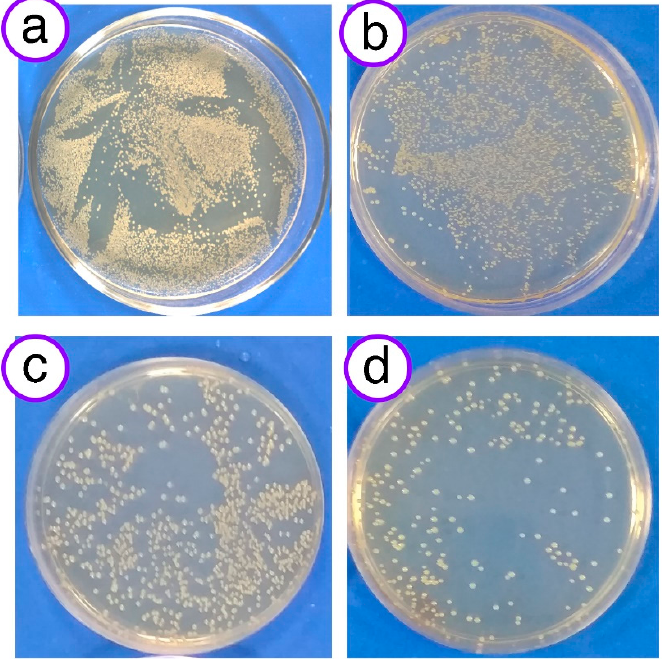
Figure 5. Photographs of Petri dishes containing methicillin-resistant St. aureus (MRSA) colony forming units (CFUs) on agar: ( a ) Pristine (unmodified VDF-TeFE scaffold); ( b ) Ti; ( c ) Ti/Cu 1; ( d ) Ti/Cu 2 . Table 5. Results of antibacterial activity assessment.